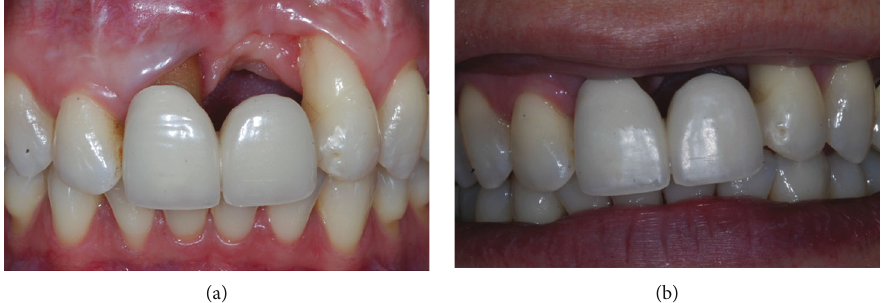
Figure 1: (a, b) Site of chief complaint revealing unsatisfactory aesthetic appearance.